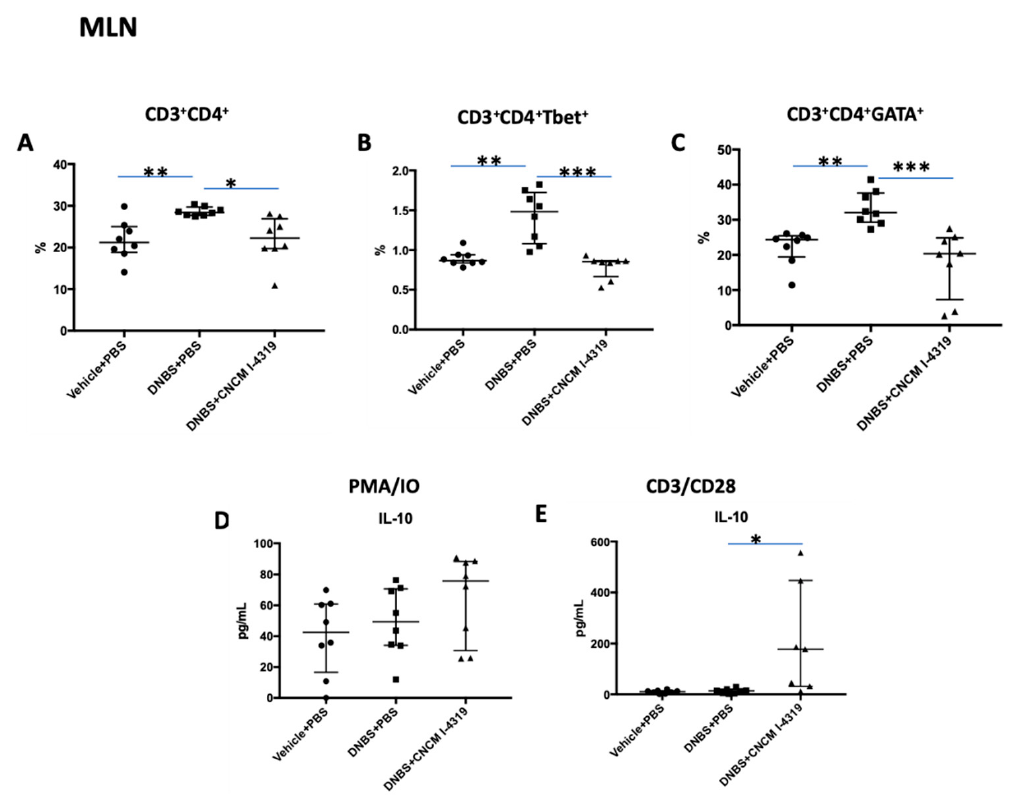
Figure 6. MLN population levels in LGI model. CD3 / CD4-positive cells and subsets detected by flow cytometry ( A – C ) and cytokine production in MLN cultures stimulated with CD3 + / CD28 + or PMA / IO ( D , E ). Control non-inflamed (vehicle-PBS), control inflamed (DNBS-PBS), B. bifidum CNCM I-4319 strain (DNBS-CNCM-I4319). * p < 0.05 ** p < 0.01 *** p < 0.001.